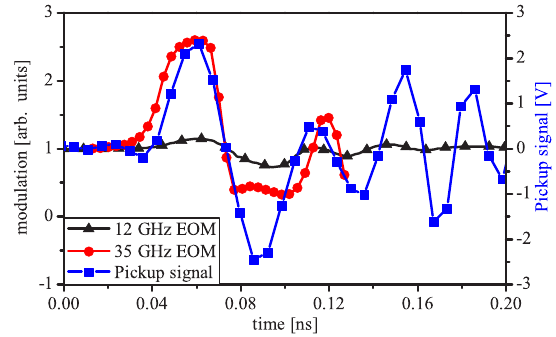
FIG. 4. Pickup signal slope dependence of the bunch charge. The blue curve shows the relative slope deviation for 128 shots. FIG. 5. Comparison between the cone-shaped pickup signal measured with a real time oscilloscope (blue curve), with a high bandwidth (red curve) and state of the art (black curve) BAM front end for a bunch charge of 80 pC.